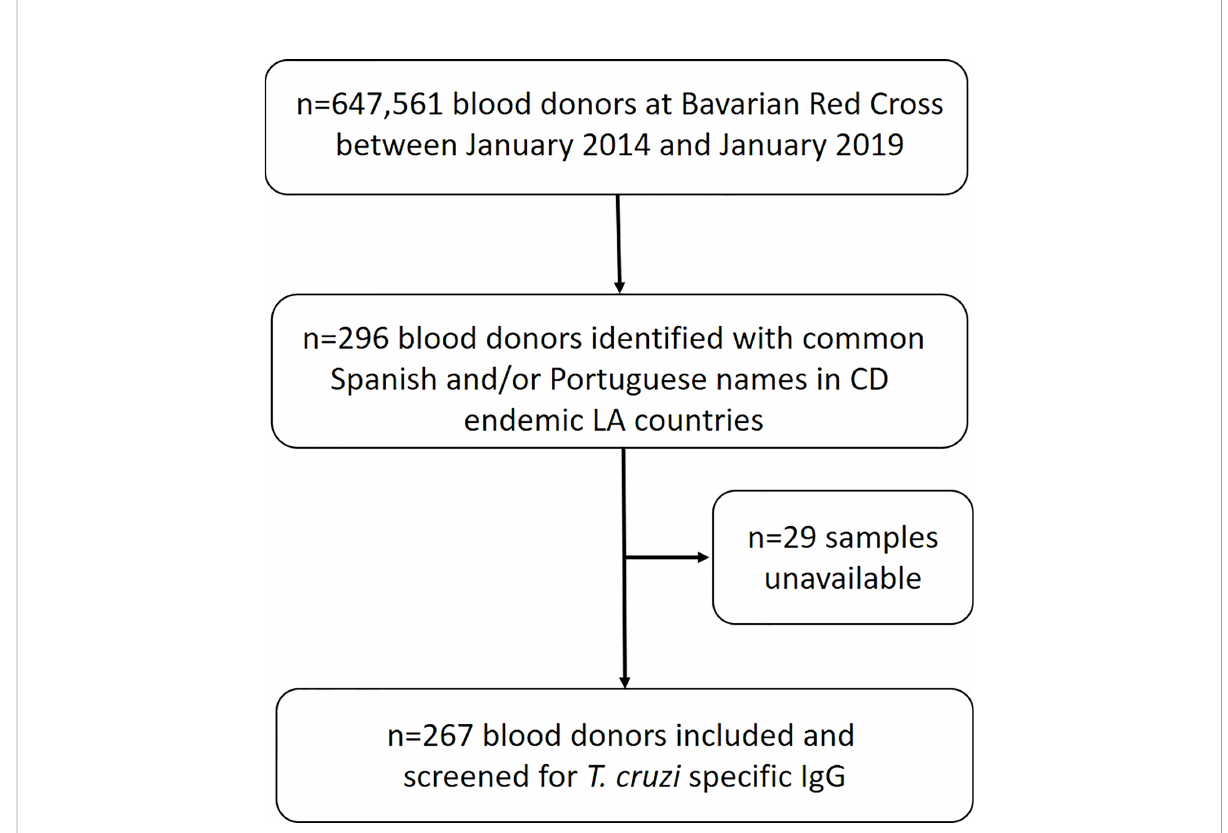
FIGURE 1 Selection algorithm of study subjects in the retrospective